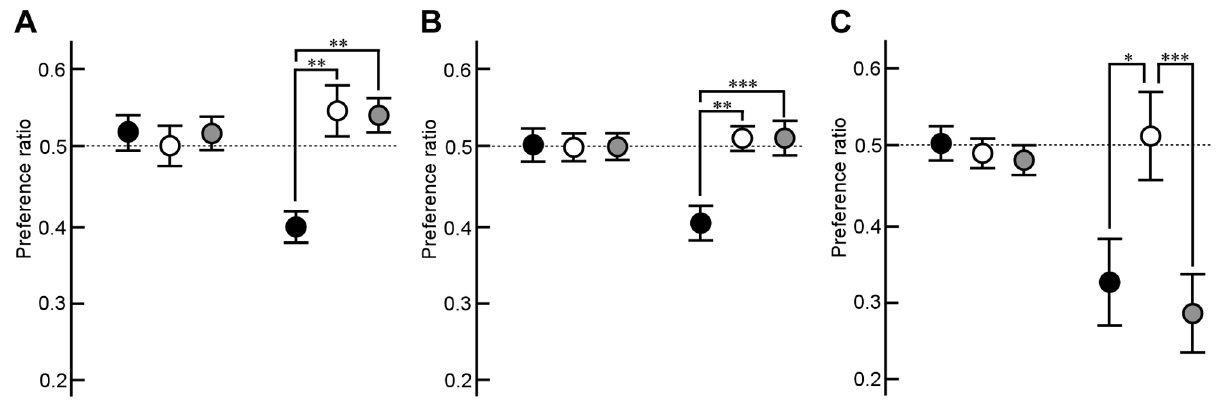
Figure 2. Avoidance of butyric acid in mice fed a hard diet, soft diet or hard diet after soft diet. Preferences were determined during a 4- min period in a Y-maze odor preference apparatus. Preference ratios between water placed on both sides of the Y-arm are shown in the three circles at the left in each figure (A, B, and C). When water was placed at the end of each Y-arm, the preference ratio of the mice fed the hard diet continuously, the soft diet continuously, the hard diet for 1 month after soft-diet feeding, or the hard diet for 3 months after soft-diet feeding was nearly 0.5. A: Preference ratios for 50% butyric acid in mice fed a hard diet (closed circles, n=15) or soft diet (open circles and gray circles, n=15 and n=15, respectively). B: Preference ratios for 50% butyric acid in mice fed only a hard diet (closed circles, n=15), only a soft diet (open circles, n=15) or a hard diet after a soft diet (gray circles, n=15) for 1 month. C: Preference ratios for 50% butyric acid in mice fed only a hard diet (closed circles, n=10), only a soft diet (open circles, n=10) and a hard diet after a soft diet (gray circles, n=9) for 3 month. *: p , 0.001; **: p , 0.0005; ***: p , 0.0001.